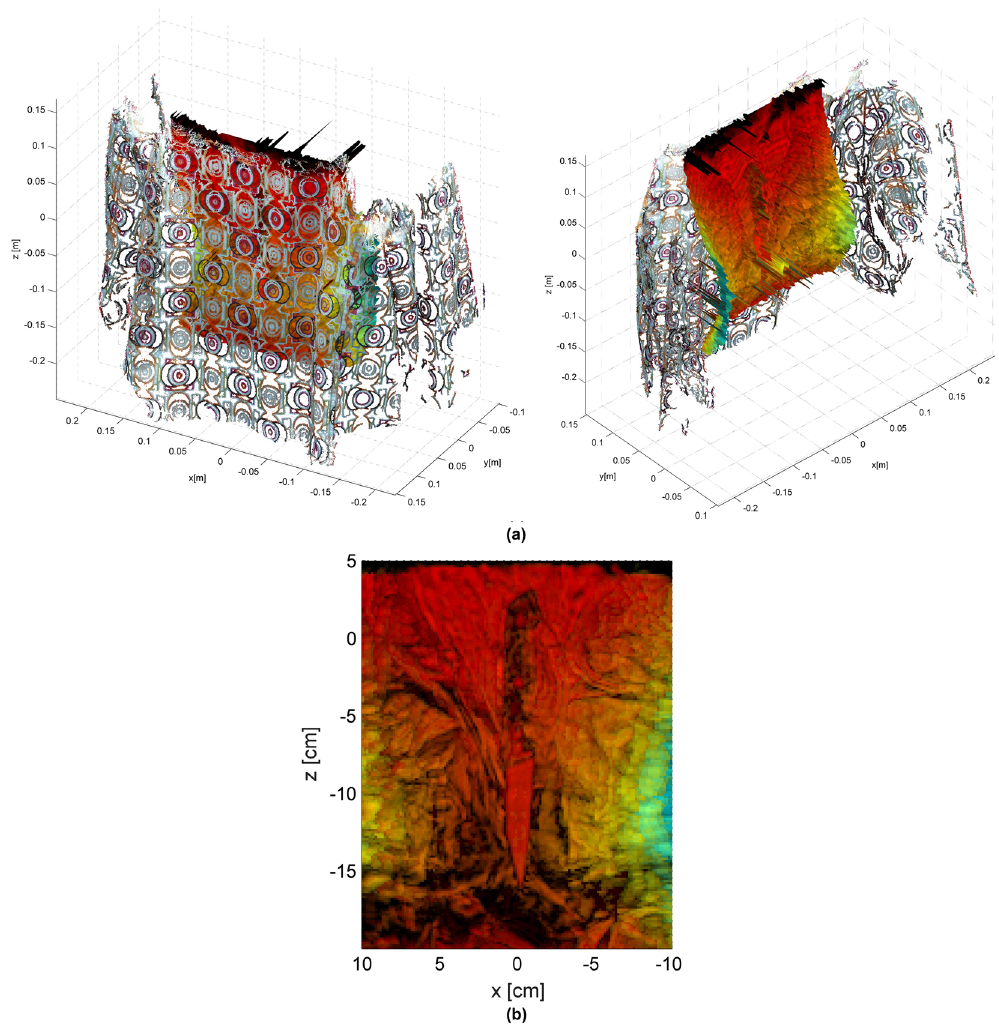
Figure 8. Mm-wave image considering all the scanner positions: ( a ) 3D model superposed with the dense point cloud extracted from image from two different perspectives; ( b ) projected mm-wave image onto XZ